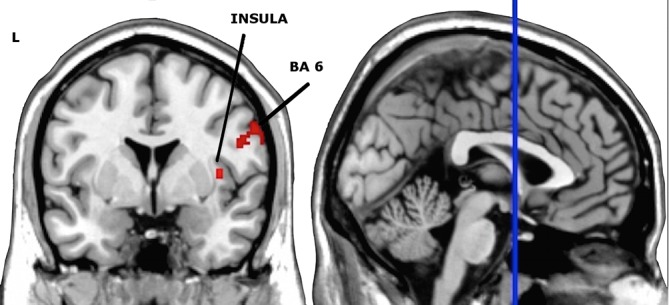
Coronal and sagittal views of the significant clusters of the post hoc paired t-tests for the active stimulation with the interaction mask of the full factorial at P<0.005, overlaid on an anatomical T1 image.The red color represents an increase in neural activation after active stimulation. Cluster sizes (AlphaSim corrected): Insula = 49, BA6 = 68. L = left; BA = Brodmann Area.